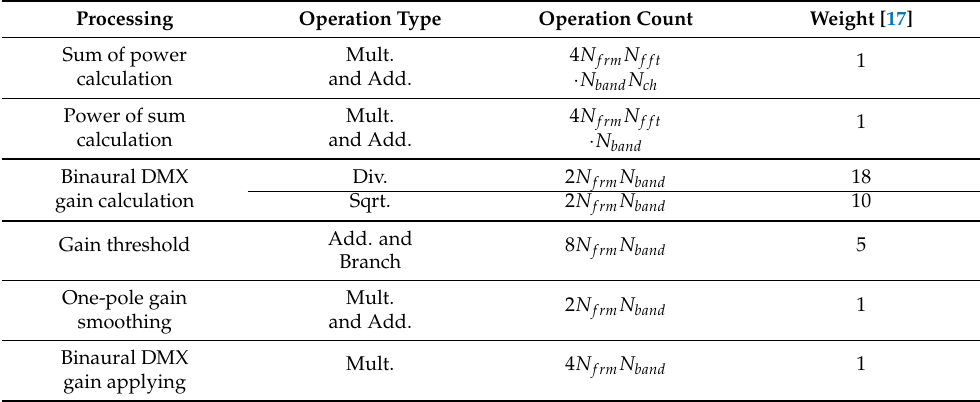
Table 2. Computational complexity of the BSC implemented on the MPEG-H 3DA